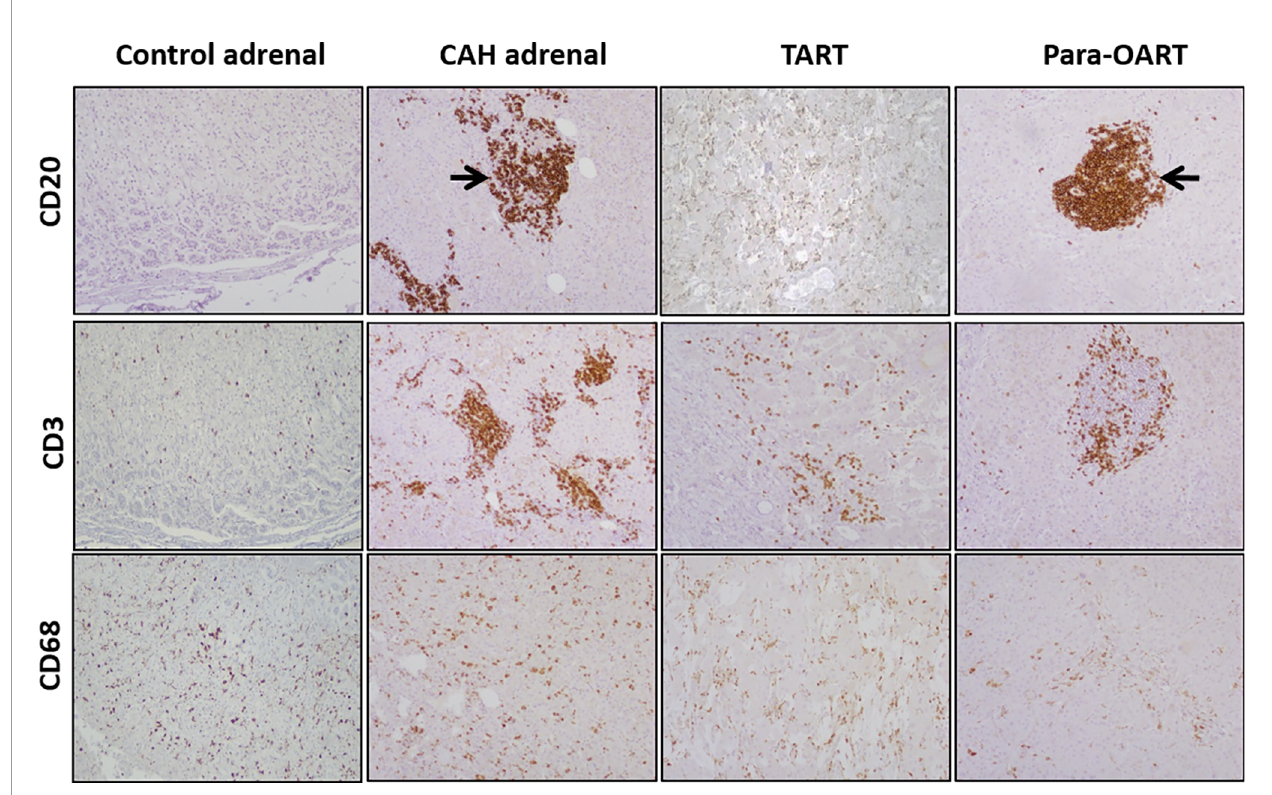
FIGURE 3 | Immunohistochemical staining for mono nuclear cell in fi ltration, labeling with CD20, CD3, CD68 in control and, CAH adrenals and TART and Para- OART. Immunohistochemical staining of ART and CAH adrenals with lymphocytic markers CD20 (B-lymphocytes), CD3 (T-lymphocytes) and CD68 (histiocytes) displays an elevated expression in lymphocytic aggregates in the adrenal parenchyma in CAH adrenals and nodular lymphocytic aggregates in para-OART (arrows). CD68 shows scattered histiocytes through the cortex or within the cortical cells (Original magni fi cation